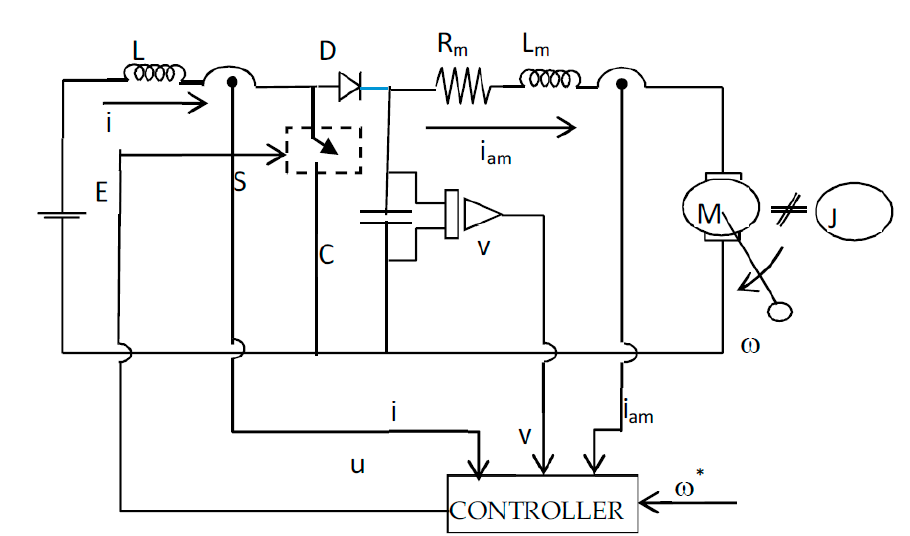
Figure 2. ETEDPOF control of Boost Converter.